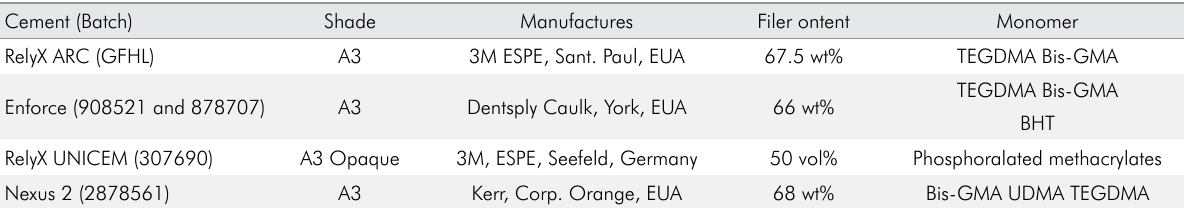
Table 1. Materials and compositions. Cement (Batch) Shade